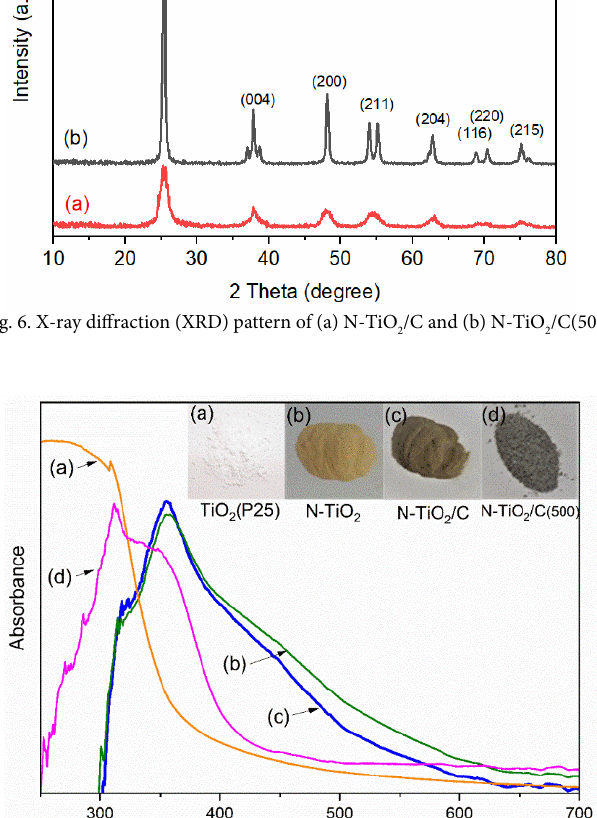
, N -TiO /C, N -TiO /C(500) and pure TiO ; inset photos show the Fig. 7. Diffuse reflectance UV-visible absorption spectra of N -TiO 2 2 2 2 samples colors which reflect the band gap Fig. 7. Diffuse reflectance UV‐visible absorption spectra of N ‐TiO 2 , N ‐TiO 2 /C, N ‐TiO 2 /C(500) and pure TiO 2 ; inset photos show the samples colors which reflect the band gap energies